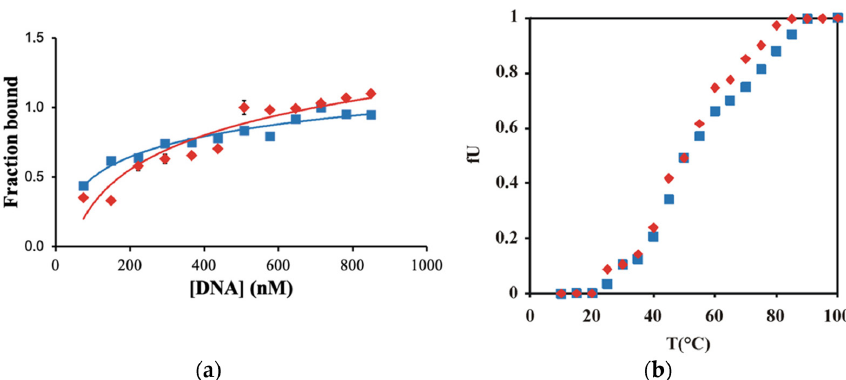
Figure 3. CD spectroscopy-based analysis of the Xyr1 variants. ( a ) Determination of the equilibrium dissociation constants (Kd). Titrations were performed with Xyr1 (blue squares) or Xyr1 A824V (red triangles) and increasing amounts of DNA ( xyn1 URR fragment, -430 to -396 bp from ATG), ranging from 0 to 900 nM. The values are means of three independent experiments. Error bars indicate standard errors of the means. If no error bar was depicted, standard deviation was below 5%. ( b ) Temperature-dependent unfolding of Xyr1 and Xyr1 A824V . The apparent fraction of unfolding (fU) of the proteins Xyr1 (blue squares) and Xyr1 A824V (red triangles) was obtained by ( θ N − θ )/( θ N − θ U ), where θ N and θ U are the values of the native and the unfolding state, respectively, and θ is the observed value of θ 222 at a given temperature. The value of fU was plotted as a function of the temperature.